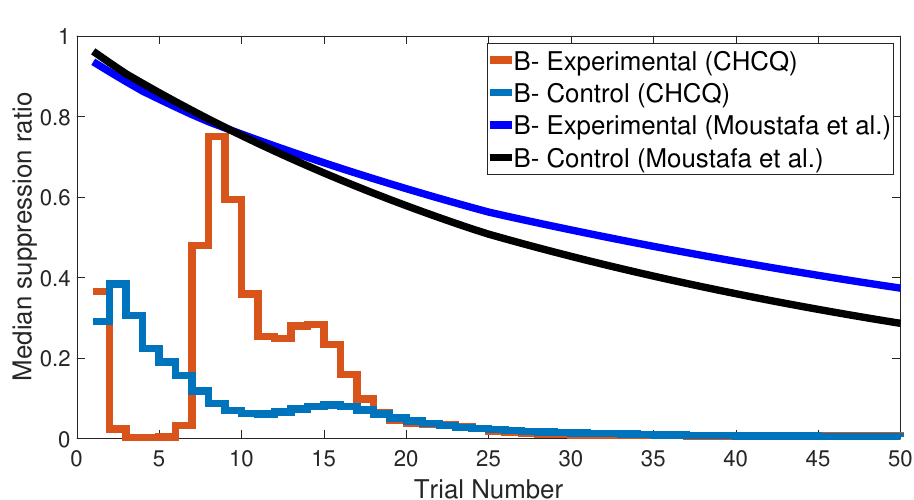
Figure 12. Extended blocking task for the intact